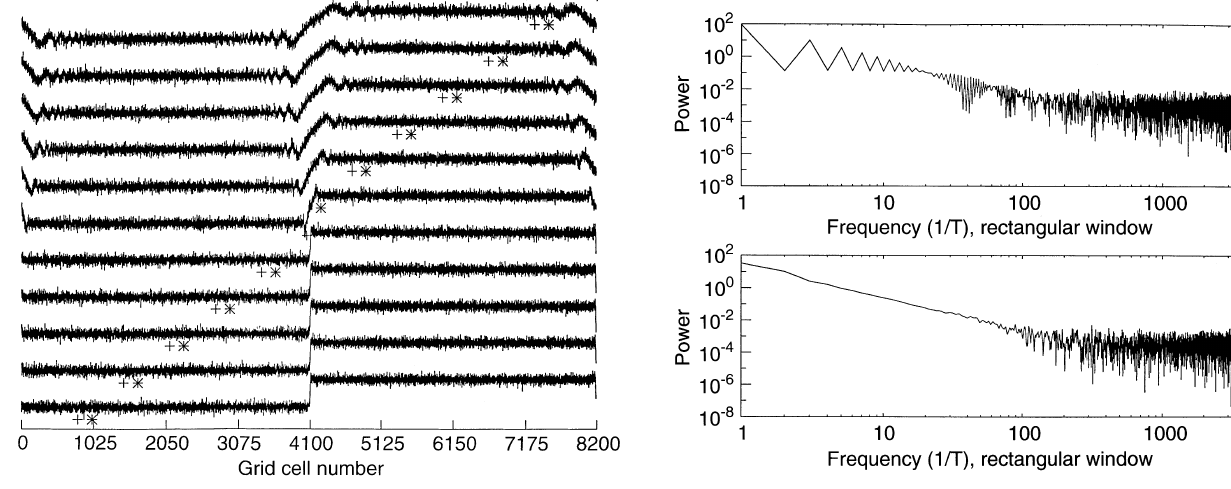
Fig. 2. Stack plot of the magnetic B ? components for the sampling time. The abscissa denotes the position ~ x in the box. This stack plot corresponds to the time evolving run. (+) denotes the position of spacecraft 1 and (*) that of spacecraft 2 for the simulation time step ~ t at which the magnetic field was plotted. For the position indicators, the same holds true as in Fig 1